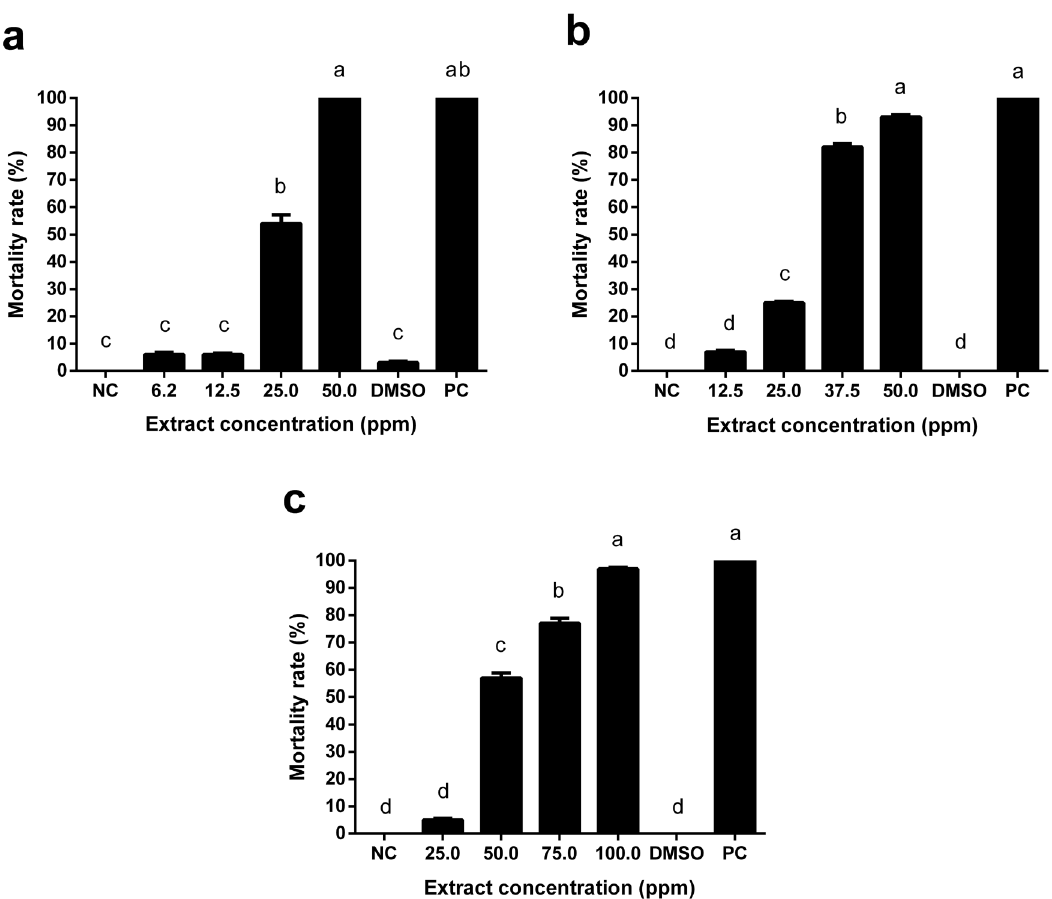
Figure 2. Mortality rate (%) of Biomphalaria glabrata embryos ( a ), newly-hatched ( b ) and adults ( c ) exposed to the ethanolic crude extract of the Persea americana stem bark. Embryos were exposed for 144 h, while newly-hatched and adults were exposed for 96 h. Results are expressed as mean ± standard deviation. One-way ANOVA followed by Tukey’s multiple comparisons test. Different letters indicate differences between groups (p < 0.05). (NC) negative control; (PC) positive control (niclosamide); (DMSO) dimethylsulfoxide – solvent